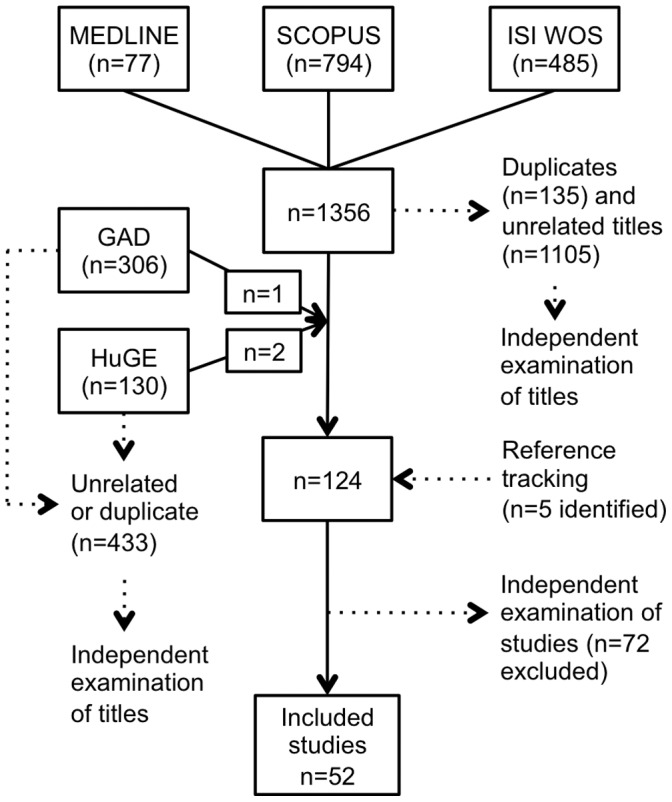
Study flow diagram.